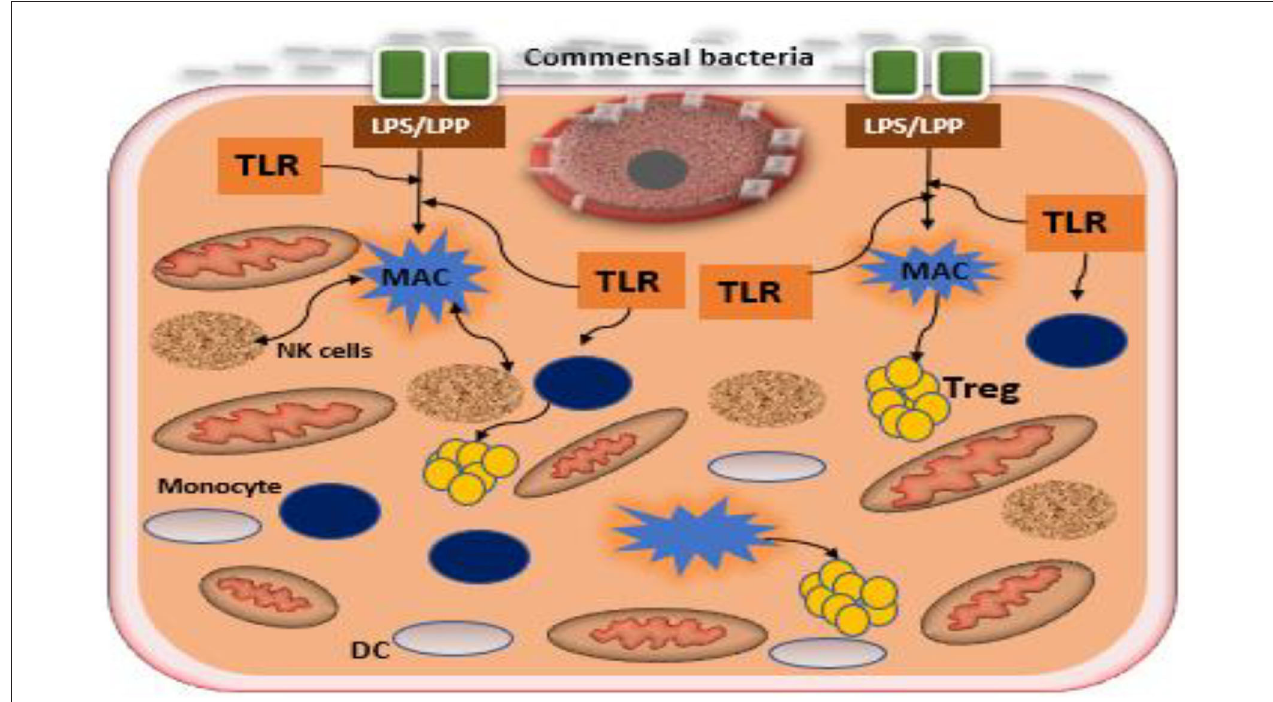
FIGURE 2 | Interaction between commensal bacteria and toll like receptors of the trophoblast in the formation of regulatory cytokines. Commensal bacteria present at the epithelium of the uterus promote the induction of regulatory cytokines by trophoblast and macrophages. Macrophages secrete antimicrobial products that mitigate commensal overgrowth and prevent invasion of pathogenic bacteria. Recognition of bacterial products such as LPS or LPP by trophoblast potentiates the expression of anti-inflammatory factors, increasing T regulatory cells (Tregs), and promoting tolerance. TLR, toll-like receptor; DC, decidual cell; LPS, lipopolysaccharide; MAC, lipoprotein